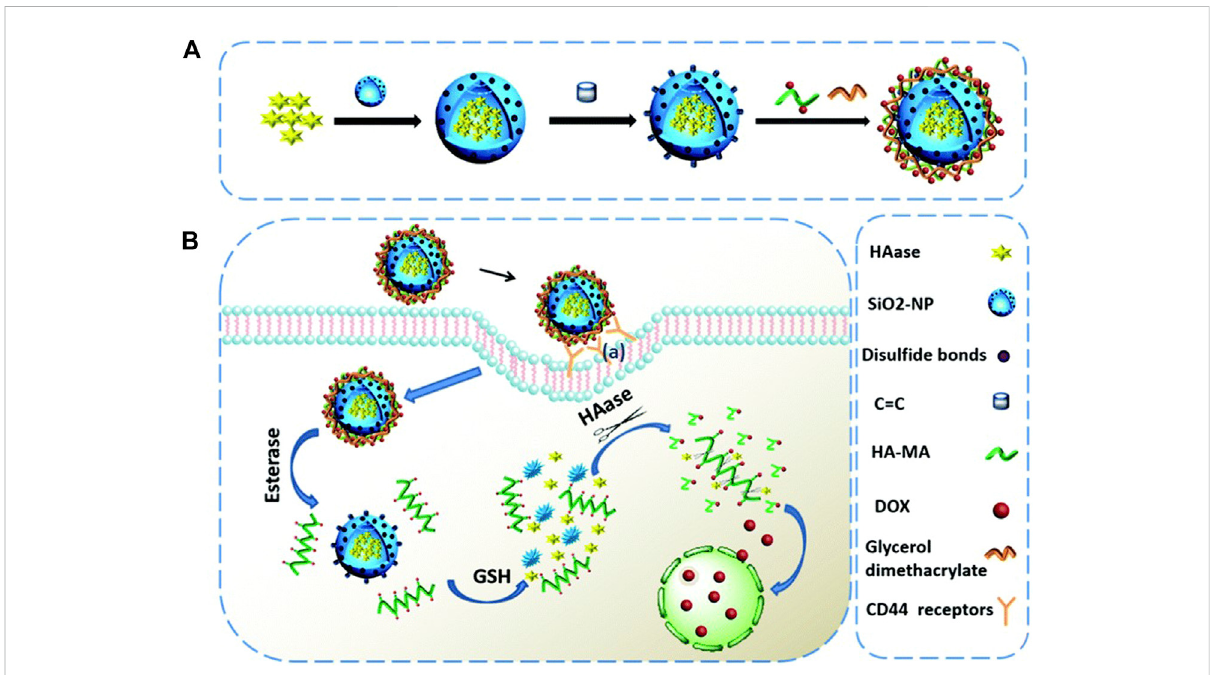
FIGURE 7 Schematic representation of (A) the fabrication of the HAase@SiO 2 @prodrug nanoplatform and (B) the tumor targeted cargo delivery, dual responsive cargo release and intracellular generation of cytotoxic antitumor drugs based on this nanoplatform. Reproduced with permission from Ref. (Chen et al., 2018).